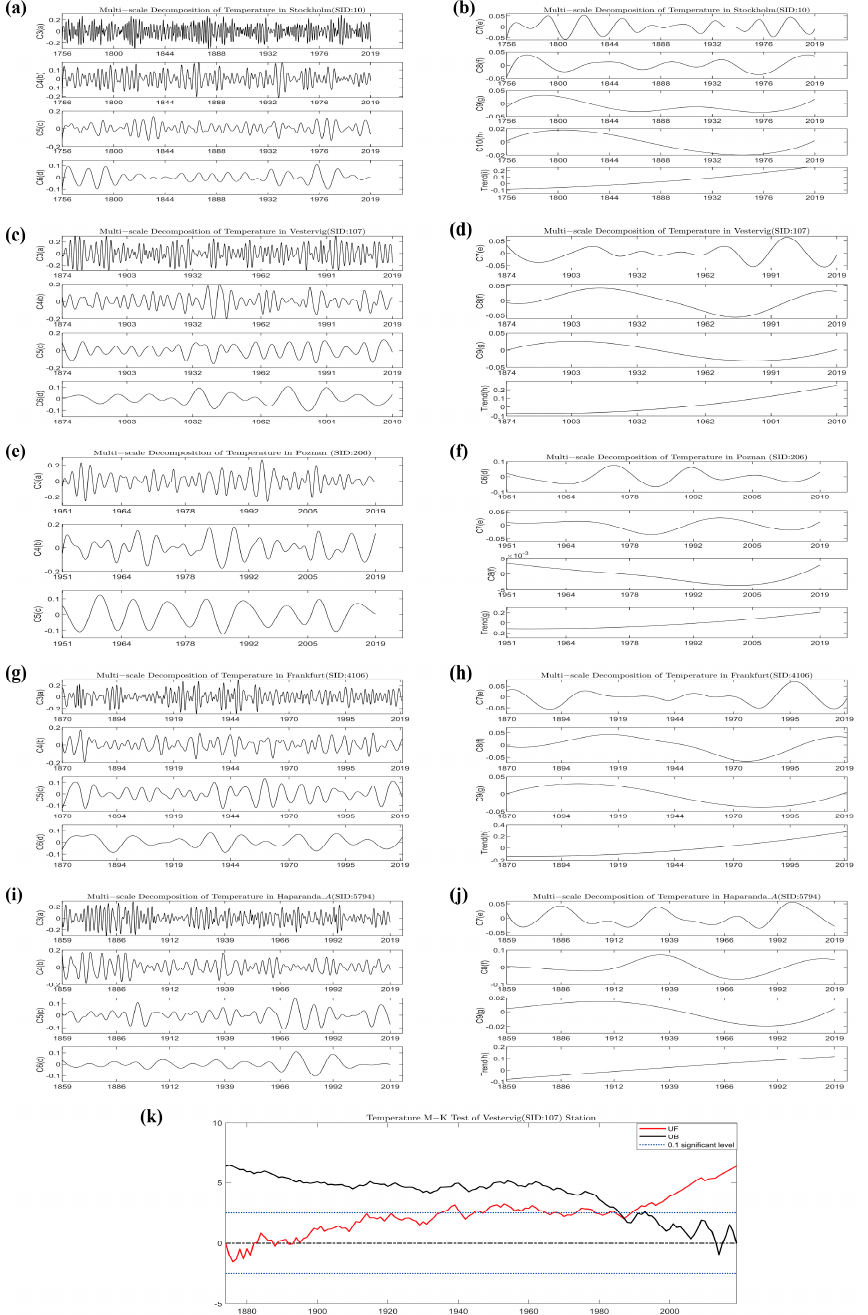
Figure 4. IMFs and trends of mean monthly temperature in Stockholm station ( a , b ), Vestervig station ( c , d ), Poznan station ( e , f ), Frankfurt station ( g , h ), and Haparanda_A station ( i , j ); temperature M-K test of Vestervig station ( k ). Table 4. Multi-scale periodic analysis of temperature in areas around the Baltic Sea area (BSA).